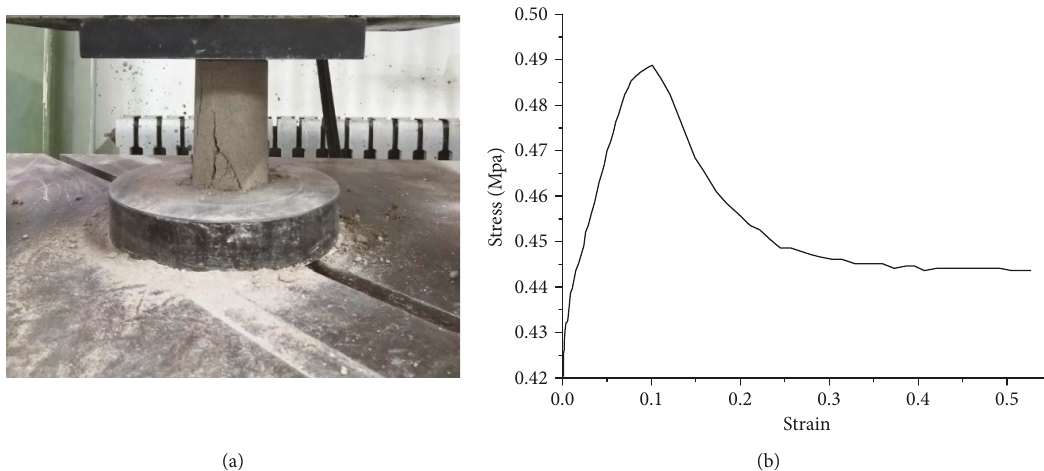
Figure 6: Mechanical tests of similar material. (a) Test specimen. (b) Stress-strain